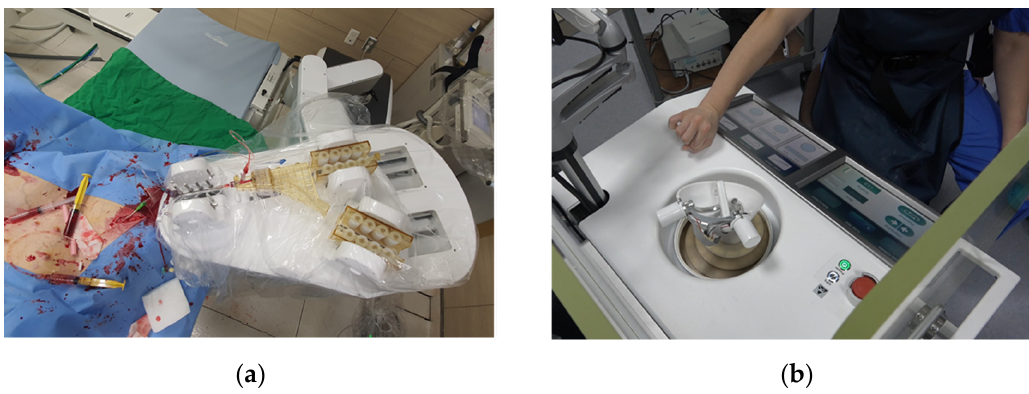
Figure 15. Setup of the animal experiment. ( a ) The slave robot beside the operation table and ( b ) the physician at the master console.